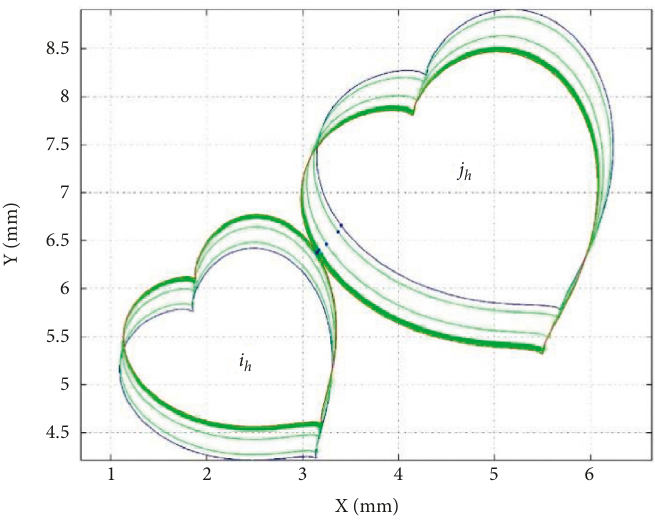
Figure 8: Collision process of heart-shaped particles.